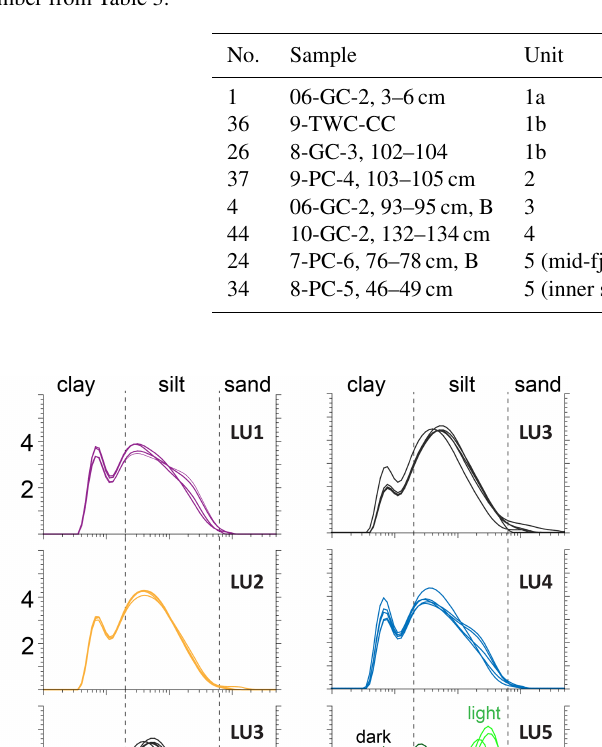
Table 4. Key radiocarbon dates and calibrated ranges defining basal ages of lithologic (sub-)unit boundaries. Calibrated ages and uncertainty are rounded to 100 years, with the mean age from the calibrated age range reported. The first column refers to the radiocarbon date index number from Table 3.